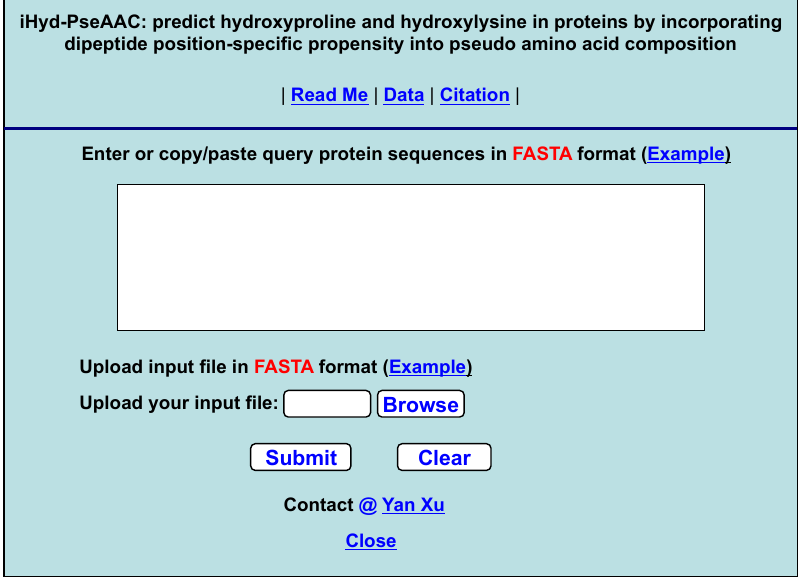
Figure 4. The top-page of the web-server, iHud-PseAAC, at http://app.aporc.org/iHyd-PseAAC/. iHyd-PseAAC: predict hydroxyproline and hydroxylysine in proteins by incorporating dipeptide position-specific propensity into pseudo amino acid